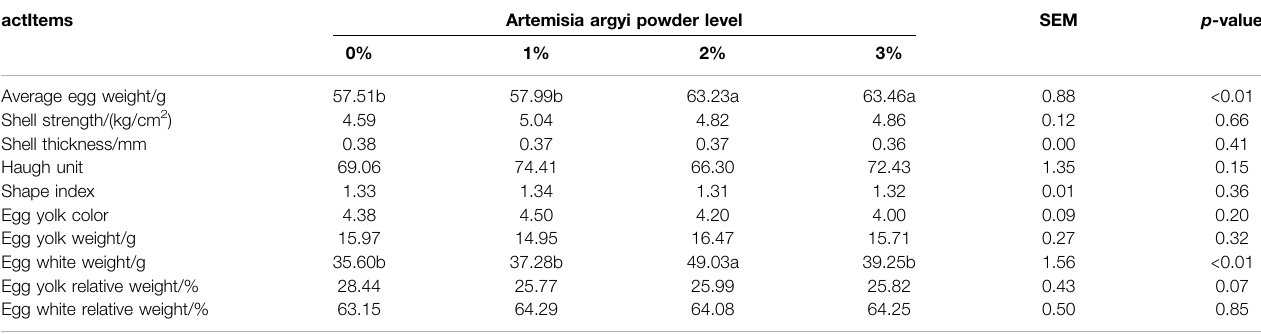
TABLE 2 | Effects of Artemisia argyi Meal on Fatty Acid Composition in Egg Yolk of Roman Laying Hens (%).